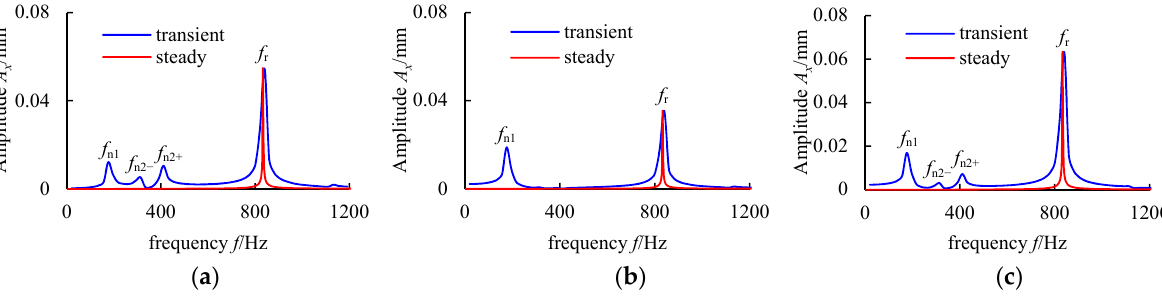
Figure 14. Frequency spectrums at different locations: ( a ) 1# bearing; ( b ) node 11 (C.G. position); ( c ) 2# bearing.